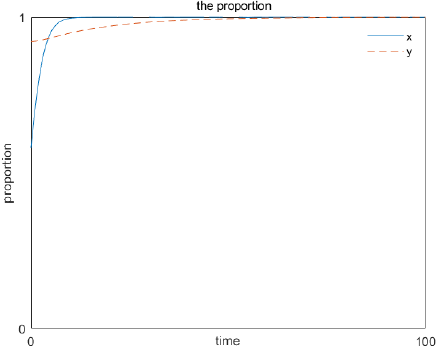
Figure 4. Evolutionary game stability strategy simulation.